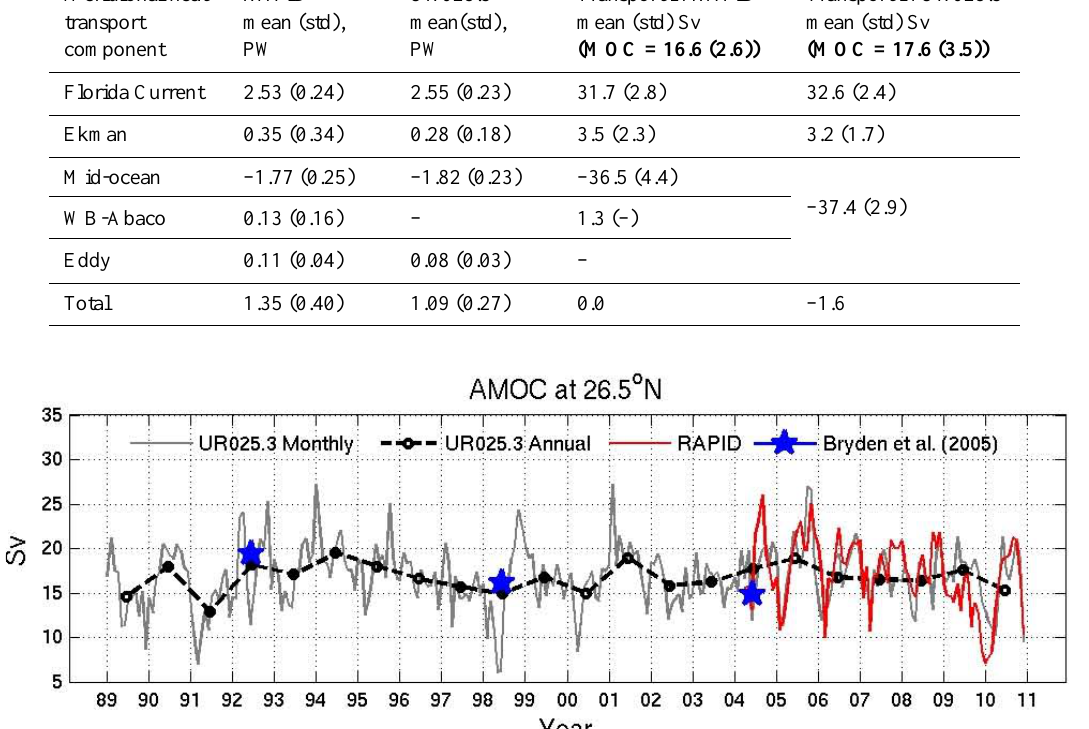
Fig. 9. Monthly and annual mean time series of the Atlantic meridional overturning circulation (AMOC), from UR025.3 in comparison with the RAPID array values from 2004–2010. Also shown are the mean section-based estimates in 1992, 1998 and 2004 (from Bryden et al., 2005). Bryden et al use an annual mean Ekman component in an attempt to represent annual mean values at these